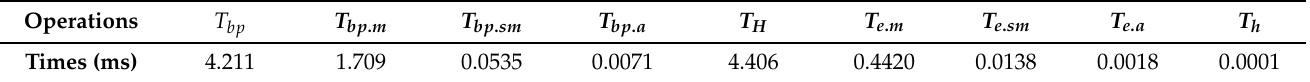
Table 3. Execution Times of Cryptographic